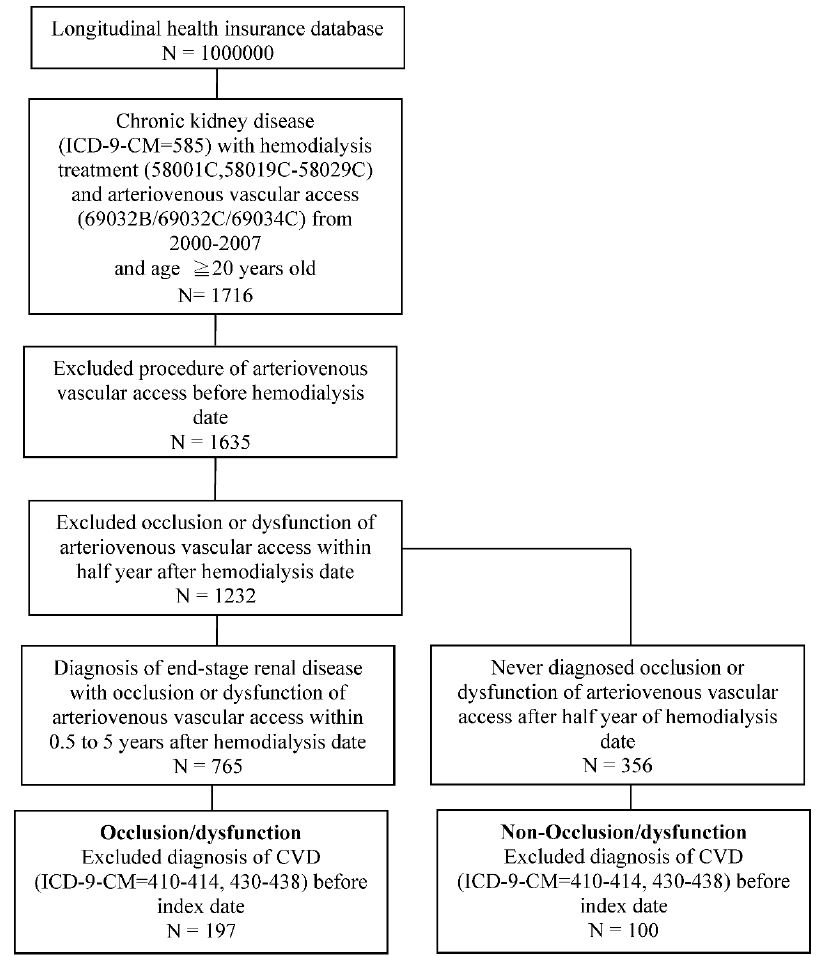
Figure 1. Flowchart describing the selection of VA dysfunction and non-dysfunction. VA group. VA, vascular access.